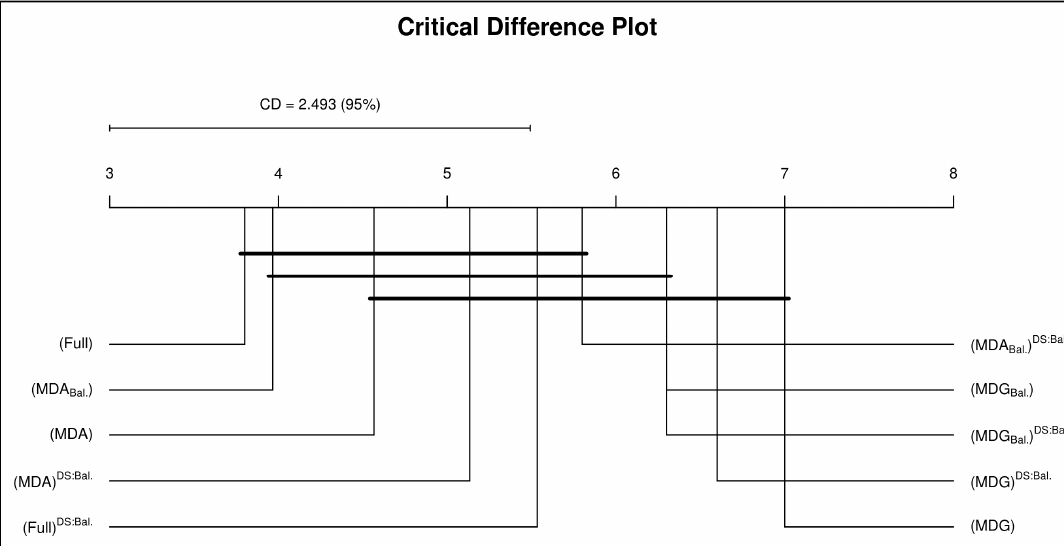
Figure 10. Nemenyi test (95% confidence level) on the RF algorithm models using different feature sets and different data balances after applying the adaptive cut-off approach.